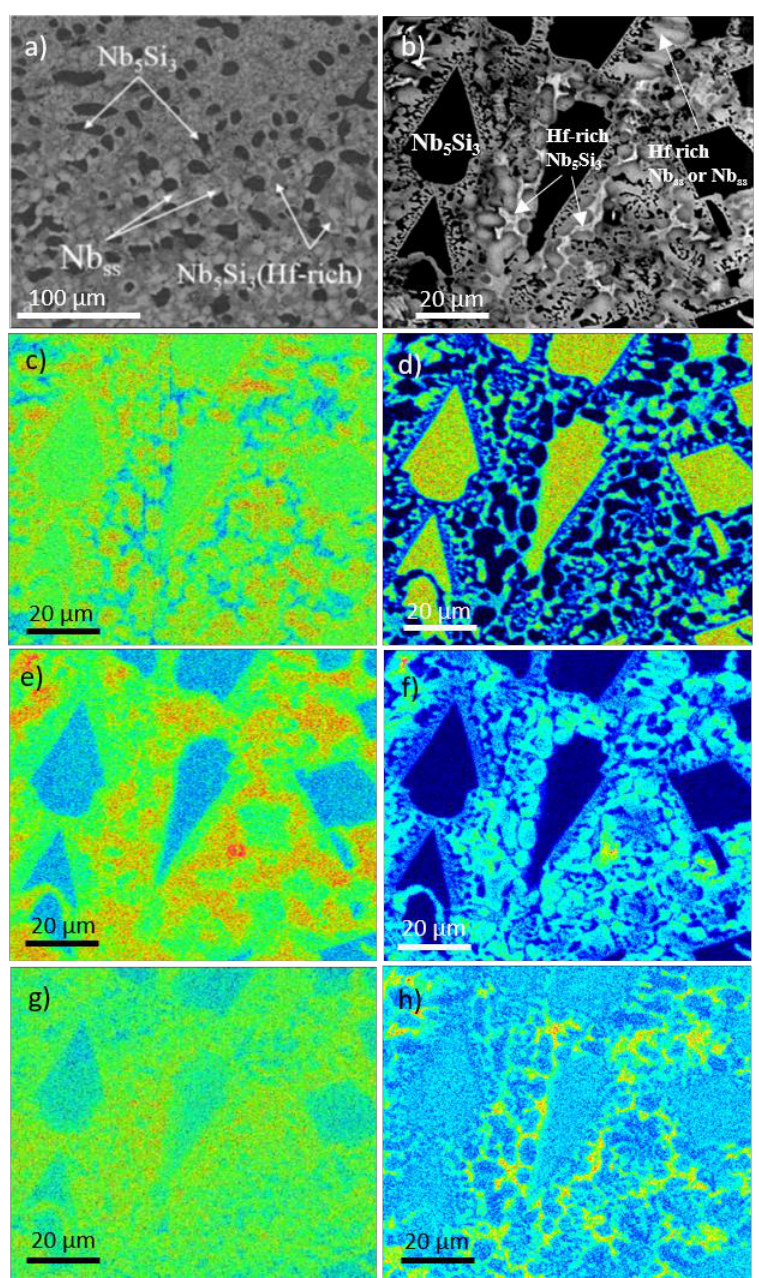
Figure 1. BSE images of the bulk of the cast alloys NbSiTiHf-5Al ( a ) and NbSiTiHf-5Al-5Cr ( b ) and EPMA X-ray maps corresponding to ( b ) where ( c ) Nb, ( d ) Si, ( e ) Ti, ( f ) Cr, ( g ) Al and ( h ) Hf. The Al and Hf concentrations in the Nb ss were essentially the same in the two alloys, and the concentrations of Cr and Ti increased in the Hf-rich Nb ss in the alloy NbSiTiHf-5Al-5Cr. The concentrations of Al in the Nb 5 Si 3 and Hf rich Nb 5 Si 3 were the same in both alloys but those of Hf and Ti were higher in the alloy NbSiTiHf-5Al-5Cr. The Al+Si concentration of the eutectic was 20.6 and 18.9 at.% in the alloys NbSiTiHf-5Al and NbSiTiHf-5Al-5Cr,